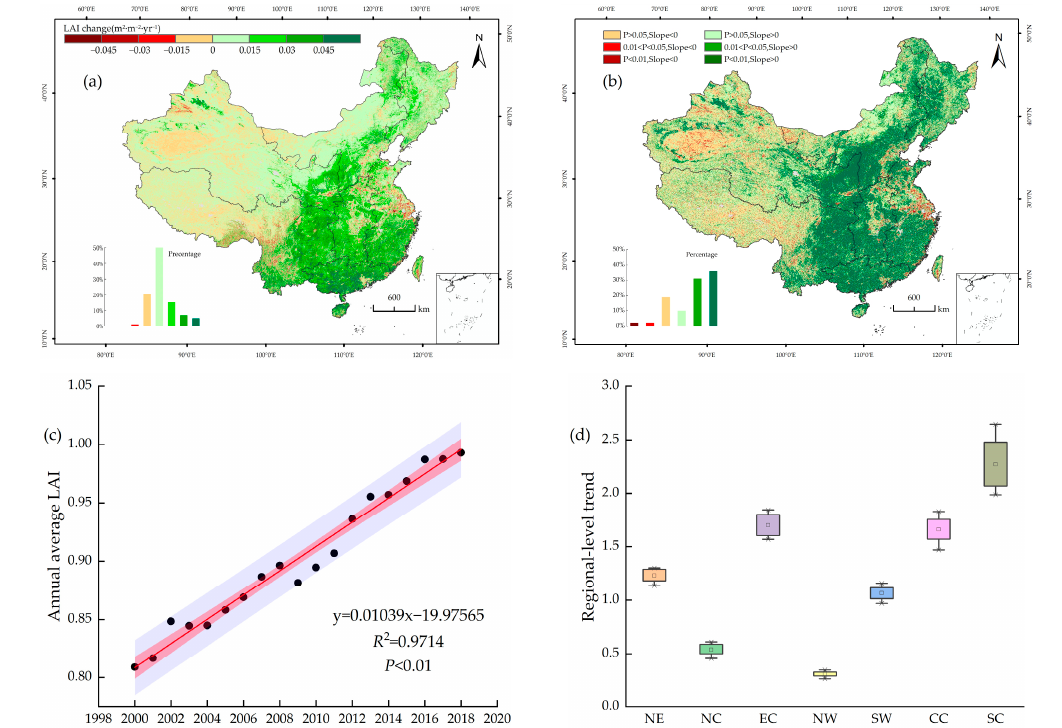
Figure 4. ( a ) Spatial distribution of the changes in the annual average LAI and ( b ) its significance level during 2000–2018. ( c ) Temporal changes in the country-level average annual LAI during 2000–2018. the red-shaded areas denote the 95% confidence interval. ( d ) Boxplots of the regional-level statistics of the LAI trends in the seven regions.